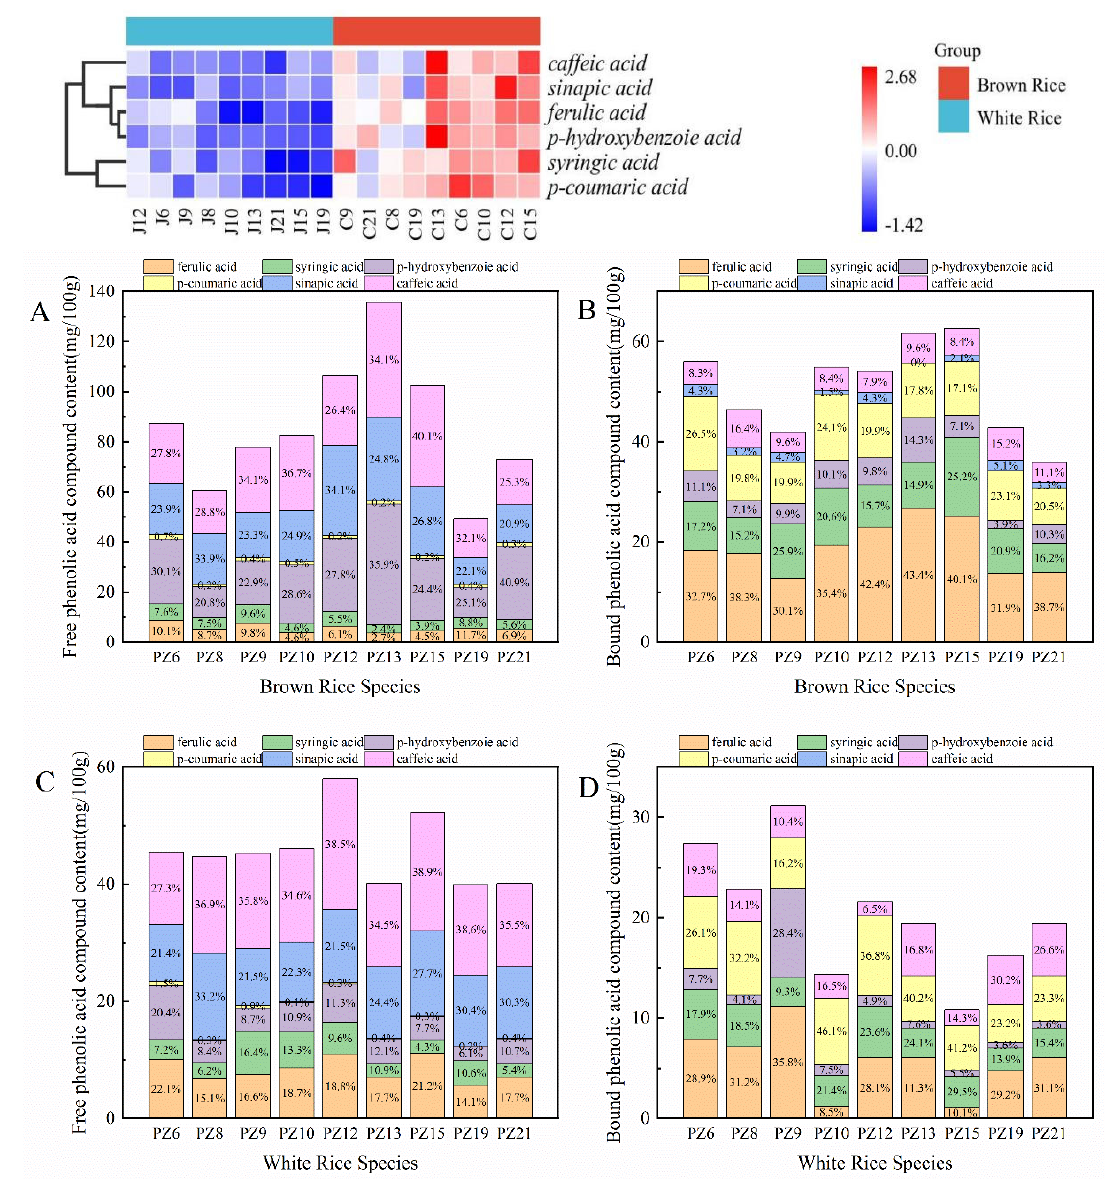
Figure 2. Heat map showing the content of six phenolic acids in brown and white rice and the percentage contribution to the total content of each phenolic compound. Free ( A , C ) and bound ( B , D ) phenolic compound content of brown and white rice, respectively. Values of each bar with lowercase letters in common are significantly different ( p < 0.05).